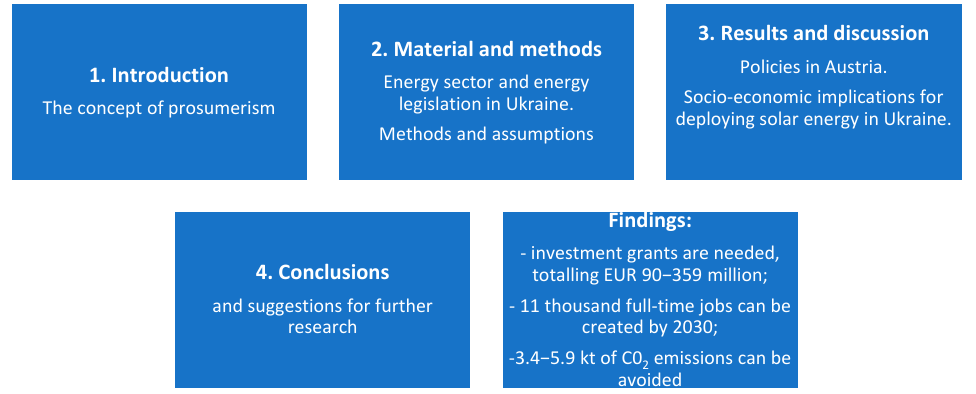
Figure 2. The graphical description of the study.